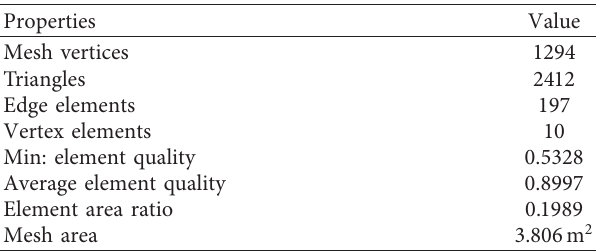
Figure 2: (a) Irregular triangular coarse mesh. (b) Irregular triangular fine mesh [16]. Table 1: Mesh statistics of